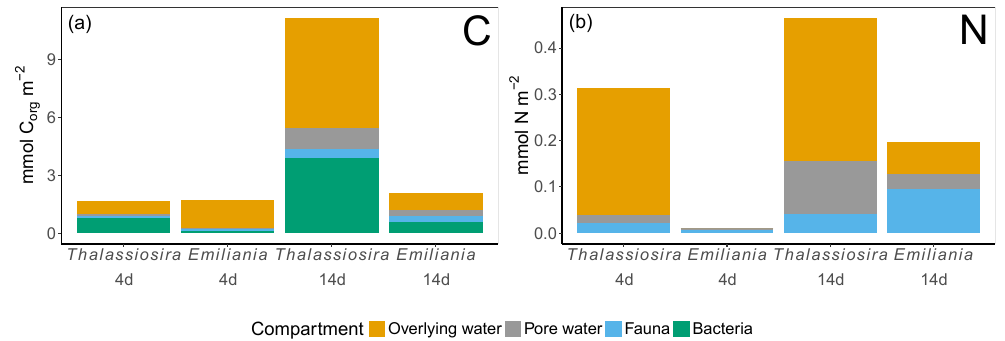
Figure 6. Processed C org (a) and N (b) in the different compartments. Note that bacterial assimilation was not quantified in terms of N. Only the first sediment centimetre could be sampled in the Emiliania 4-day